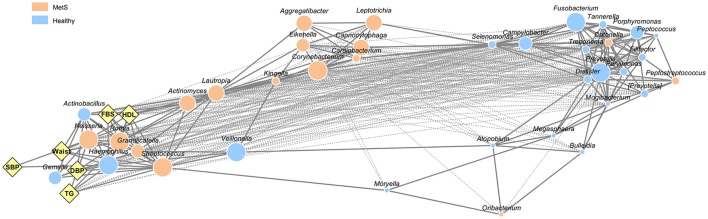
Network interaction of oral microbiome in healthy controls and MetS subjects. Edges represent significant positive (solid line) and negative (dotted line) relationships. The size of the nodes is scaled to the OTU counts of each genus. The colors reflect the bacteria enriched in healthy controls and MetS subjects as determined by Student's t-test (p < 0.05, q < 0.2). Diamonds indicate host parameters used to define MetS patients.